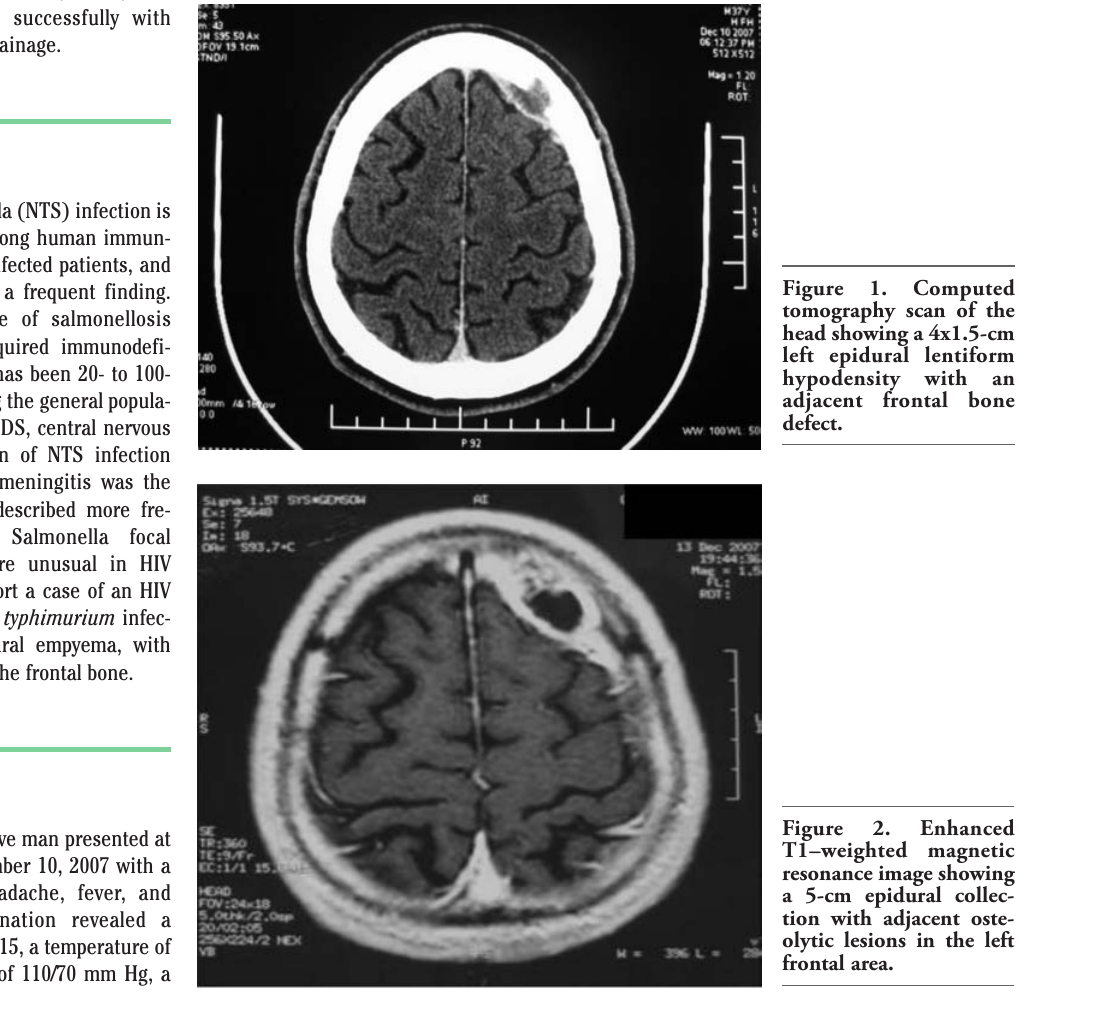
Figure 2. Enhanced T1–weighted magnetic resonance image showing a 5-cm epidural collec- tion with adjacent oste- olytic lesions in the left frontal